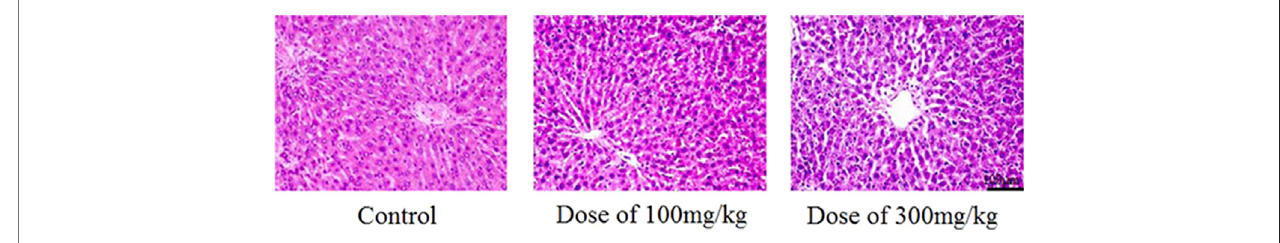
FIGURE 5 | Histological HE-staining of liver from rats after 28 days of oral treatment with and without Alginate/Chitosan/Lovastatin nanoparticles, in two different concentrations (100 and 300 mg/kg). Figure adopted from Thai et al. (2020) (https://creativecommons.org/licenses/by/4.0/).